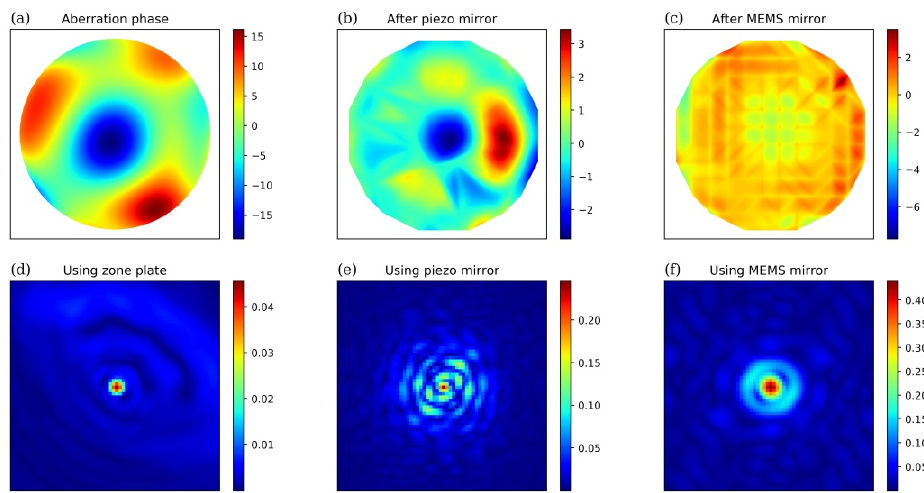
Figure 5. Residual aberrations and calculated field amplitude at the fiber end. ( a ) Initial aberration in radians; ( b , c ) residual aberrations for piezo and MEMS mirrors, respectively; ( d – f ) field amplitude at the fiber end when using zone plate, piezo, and MEMS correctors, respectively (in arbitrary units).